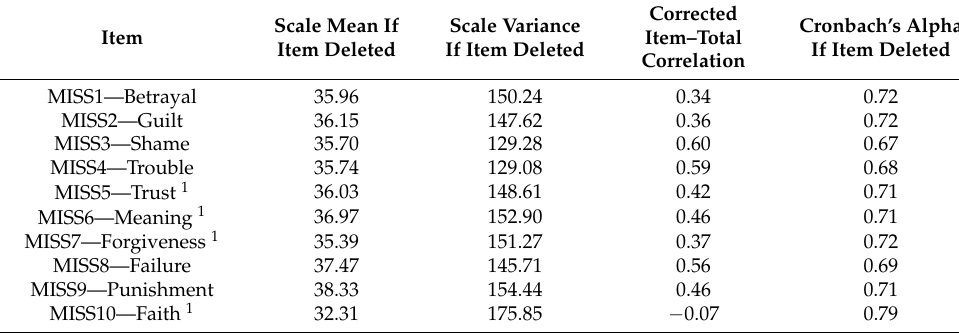
Table 4. Reliability analysis of G-MISS-HP.